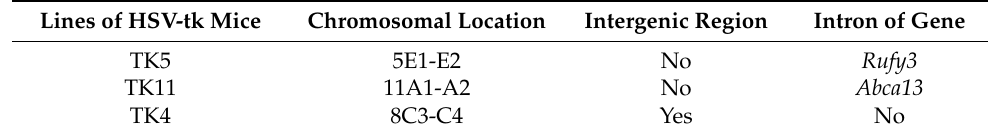
Figure 1. Analysis of integration status in mouse and the integration sites of HSV-tk . ( A ) PCR analysis of the Herpes simplex virus thymidine kinase ( HSV-tk ) gene in offspring of founder mice. PC, positive control (pCMV-TK vector), size at 390 bp; NC, negative control (wild-type KM mice); 1–11, 11 offspring with positive HSV-tk integration; 12–13, 2 offspring without HSV-tk integration; M, 100 bp marker. ( B , C ) iPCR analysis of HSV-tk transgenic mice flanking sequence of integration sites. ( B ) The PCR product of ligated Dra I digestion of genomic DNA. NC, negative control; M, 1 kb marker. ( C ) The PCR product of ligated Eco RI digestion of genomic DNA. M, 100 bp marker. Table 2. The integration sites of three lines of HSV-tk mice.